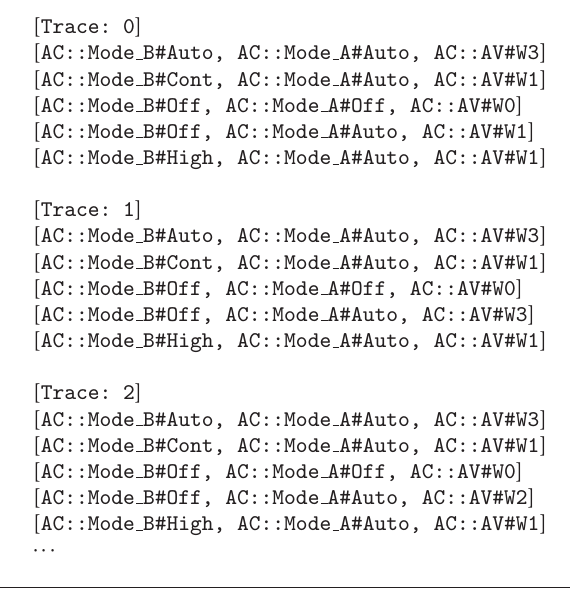
Pseudocode 4: An example output: Test